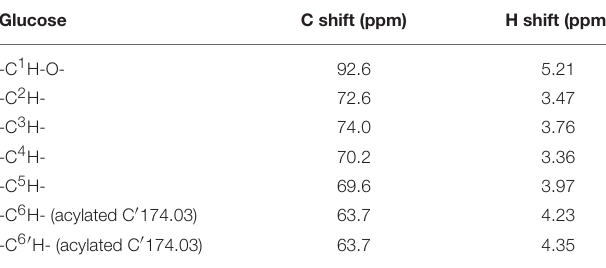
TABLE 2 | Chemical shifts of the main product, present in the purified and fractionated sample